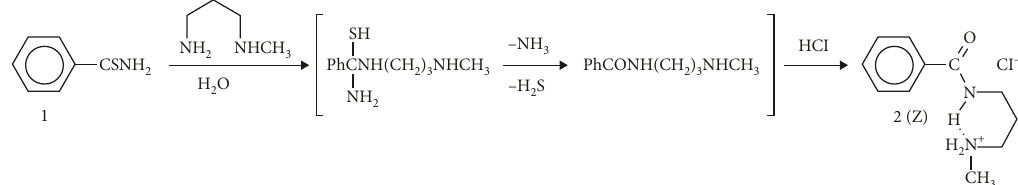
Scheme 2: An outline of the generally considered addition-elimination mechanism that has been suggested for the Z isomer 2 (great stereoselectivity).